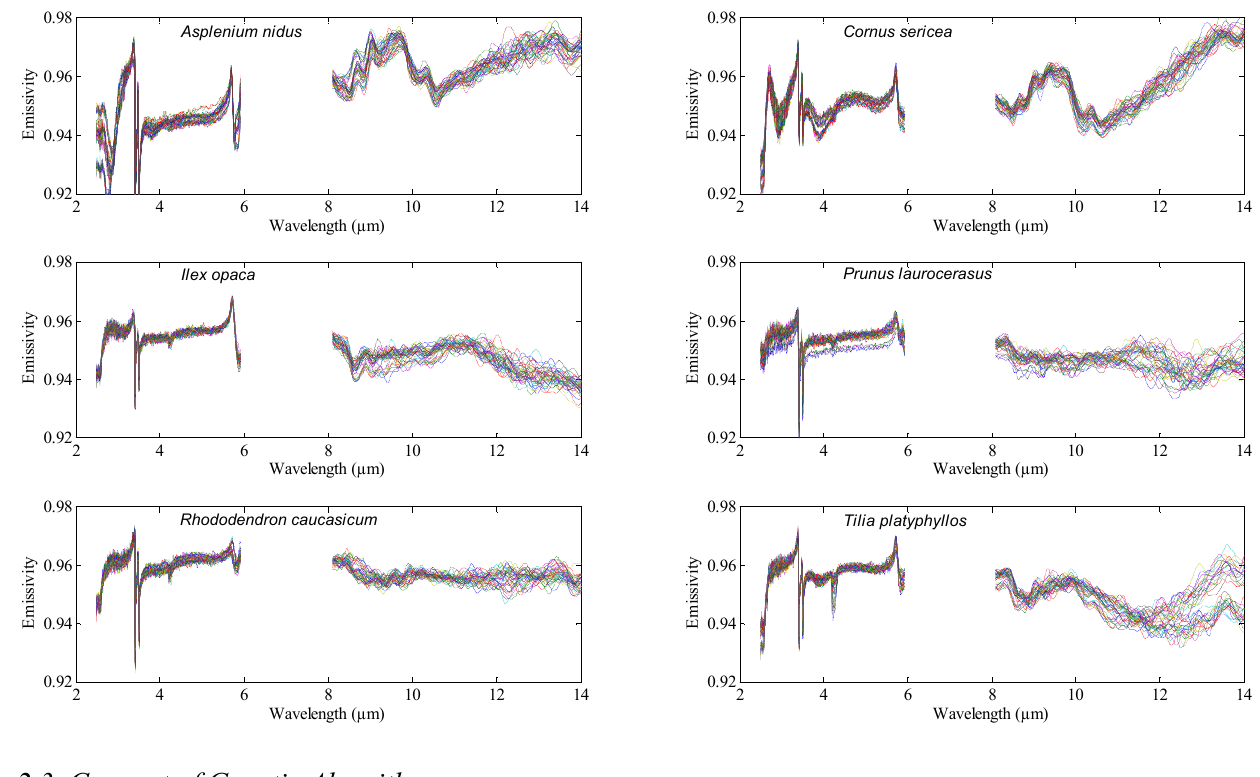
Figure 1. The spectral emissivity profiles of the six plant species in the mid-wave and thermal infrared